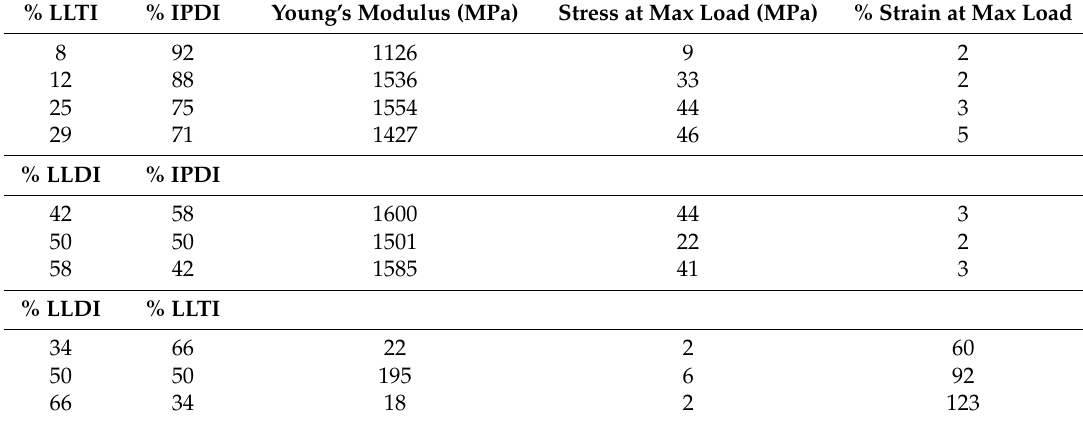
Table 1. Average Young’s modulus, maximum stress and maximum strain of PUs with different isocyanate ratios.